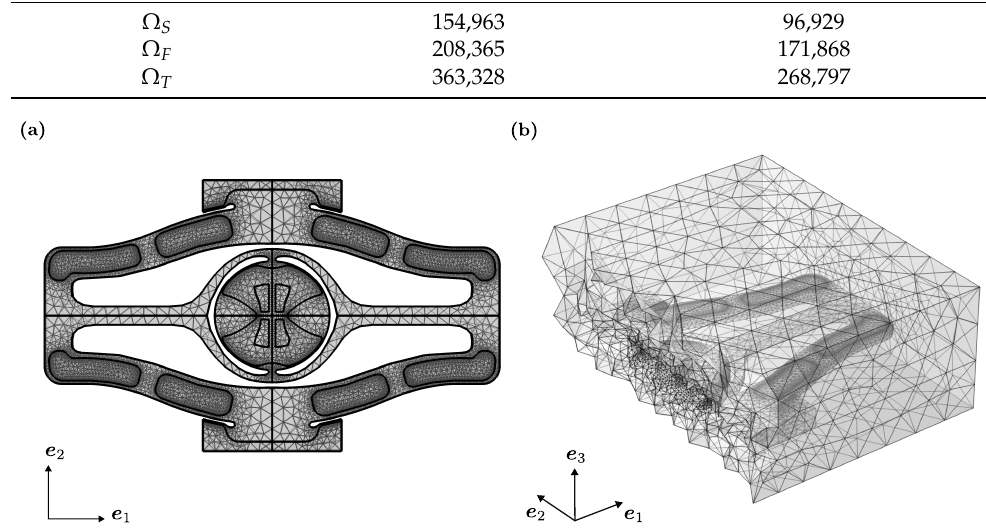
Figure 11. Computational domains for Micromirror 2: upper view of Ω S ( a ) and internal cut section of Ω F generated with an e 2 − e 3 plane passing through the centre of the box ( b ).